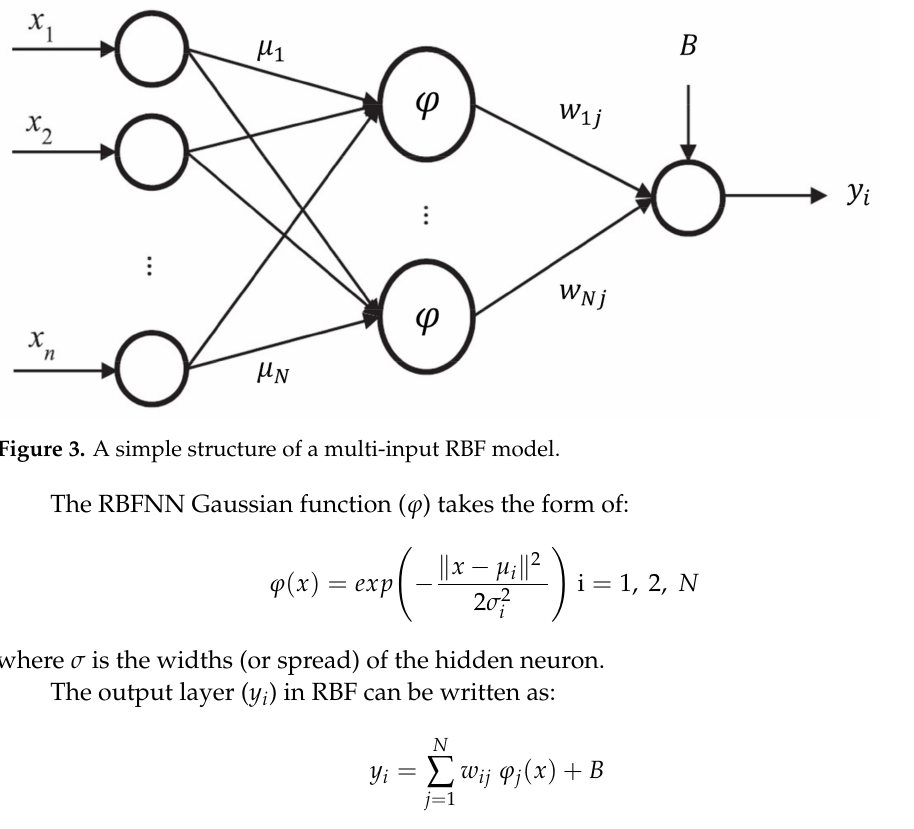
and output neuron; and N is the number of hidden-layer neurons. The constant term B represents a